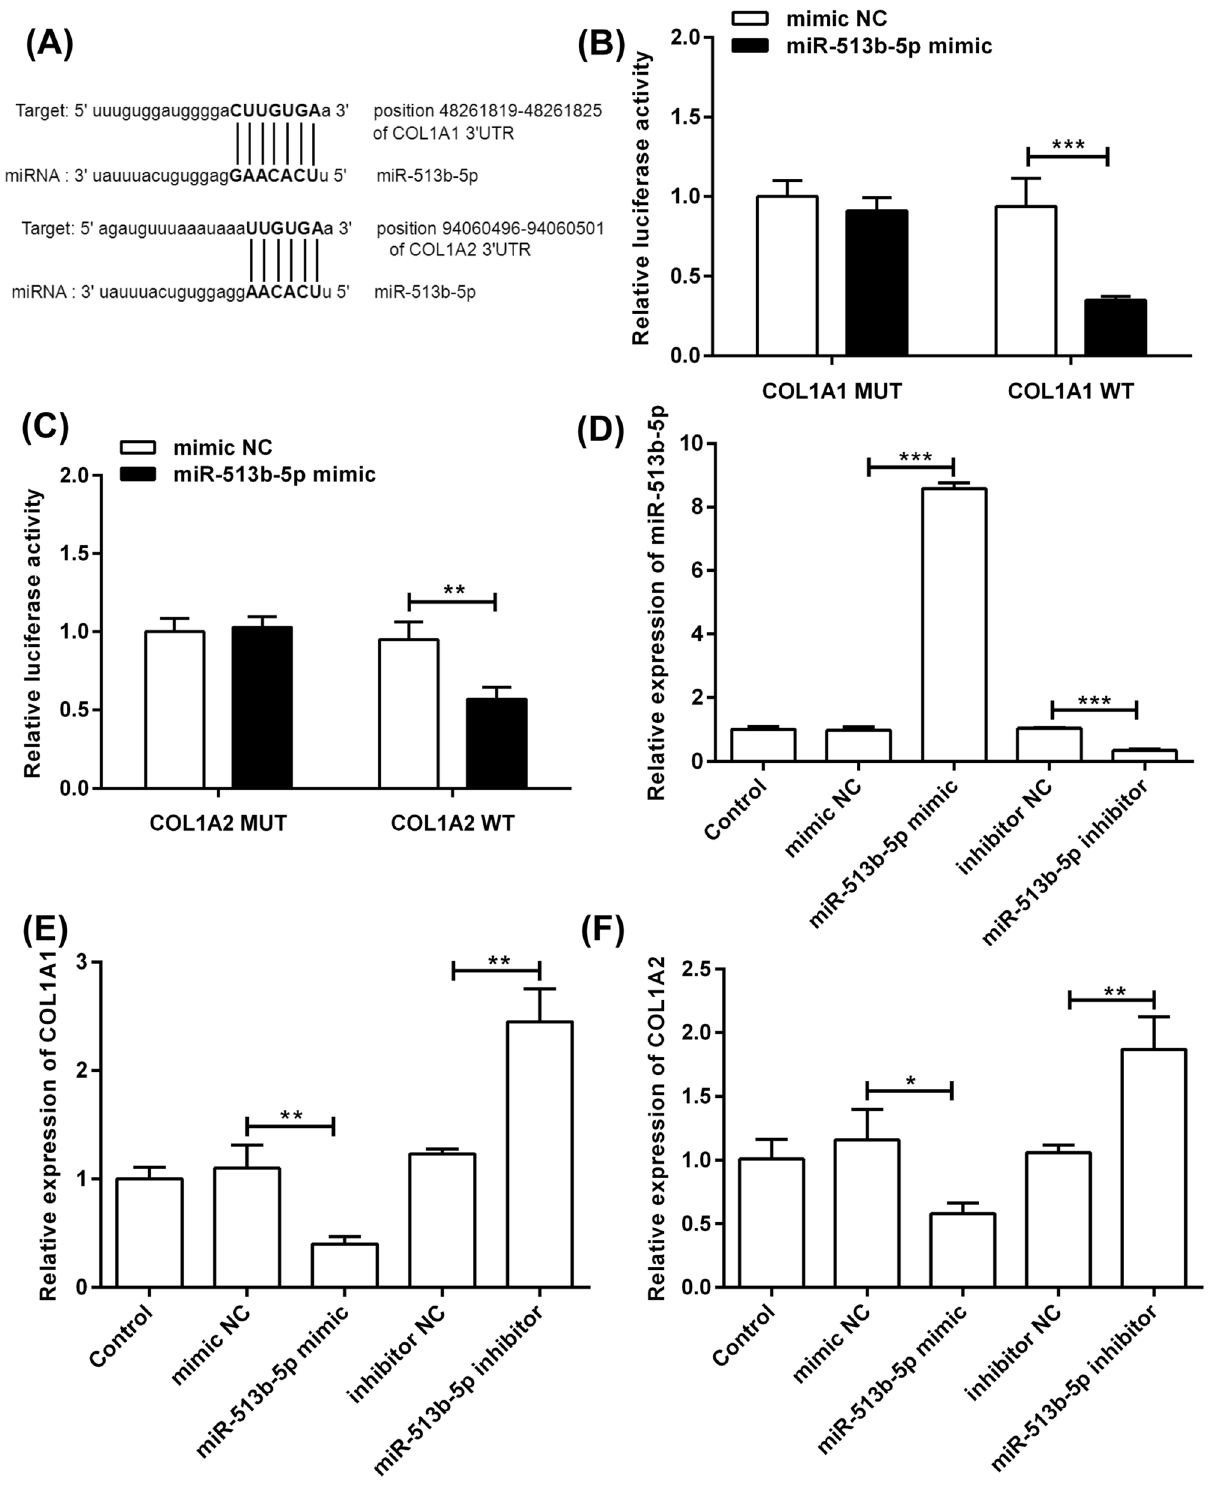
Figure 2. MiR-513b-5p directly targeted COL1A1 and COL1A2 and inhibited their expression. ( A ) Schematic representation of miR-513b-5p binding sites in COL1A1-3 ′ UTR and COL1A2-3 ′ UTR. ( B ) The dual luciferase report assay confirmed the targeting relationship between miR-513b-5p and COL1A1-3 ′ UTR. ( C ) The targeting relationship between miR-513b-5p and COL1A2-3 ′ UTR was proved by the dual luciferase report assay. ( D ) The miR-513b-5p mimic and inhibitor transfected with the HASMCs. ( E ) MiR-513b-5p inhibited the COL1A1 mRNA expression. (F) MiR-513b-5p inhibited the COL1A2 mRNA expression. All data presented as mean ± standard deviation, and three independent experiments were carried out. Compared with mimic NC or inhibitor NC group, * p < 0.05, ** p < 0.01, and *** p < 0.001. Student’s t test with two-sided was